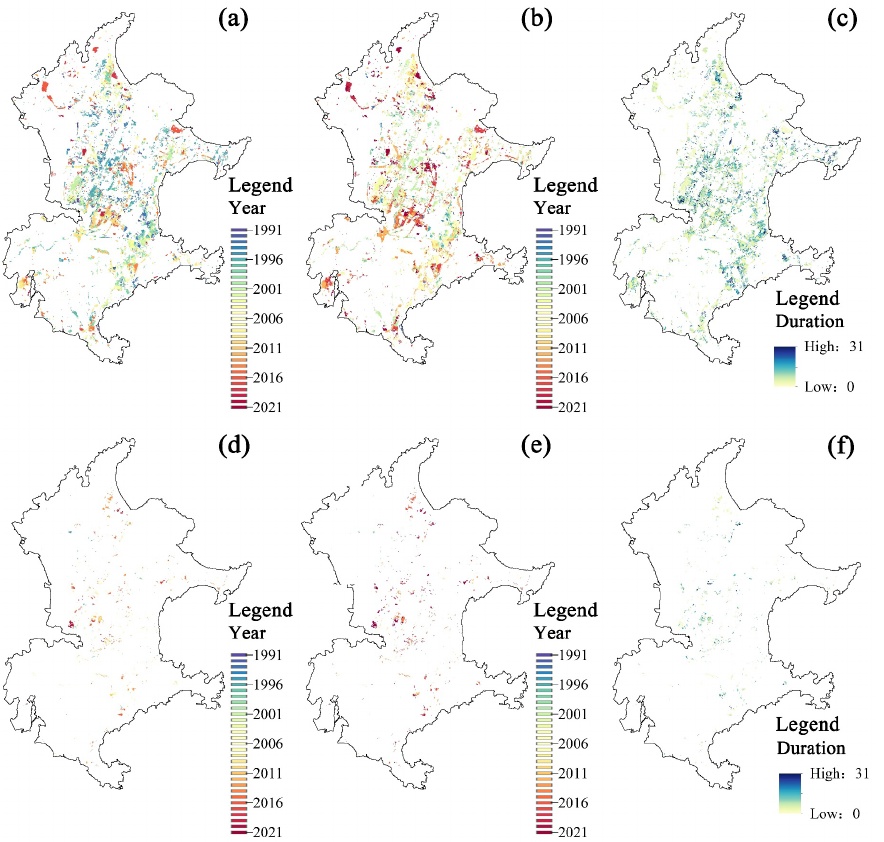
Figure 7. Spatial–temporal distribution of ecological quality (EQ) disturbance in Haitan Island from 1991 to 2021. Different colors represent different years. ( a ): start time of the first disturbance; ( b ): end time of the first disturbance; ( c ): duration of the first disturbance; ( d ): start time of the second disturbance; ( e ): end time of the second disturbance; ( f ): duration of the second disturbance. Table 4. Area statistics of ecological quality (EQ) disturbance in 31